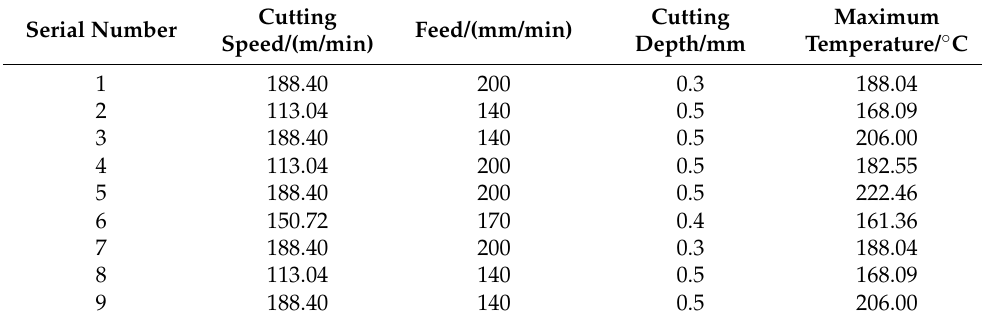
Table 5. Comprehensive test results.